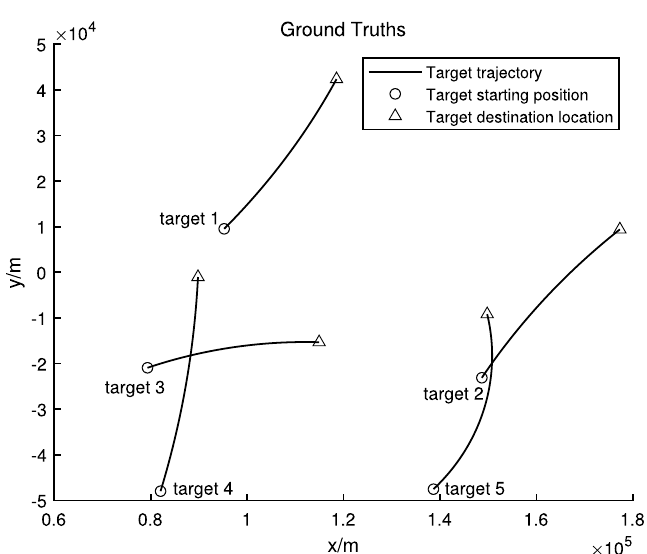
Fig. 9 True trajectories of 5 targets on the 2D plane